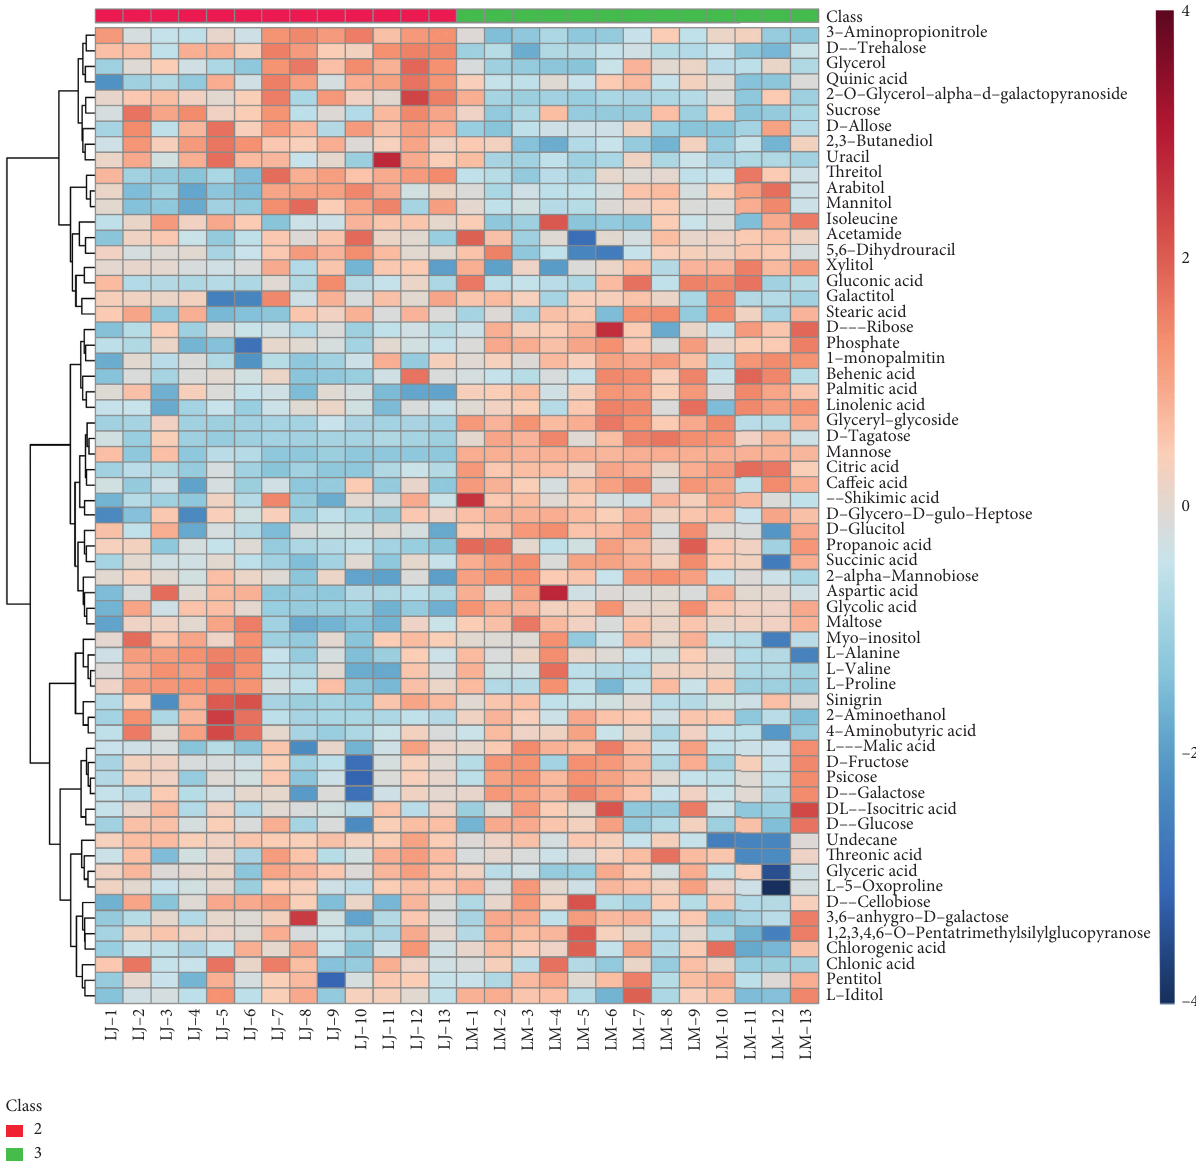
Figure 1: (a) GC-MS TIC chromatograms. (b) Heatmap obtained after hierarchical cluster analysis of the metabolite profiles of LJ and LM. Columns and rows represent different samples and individual metabolites,